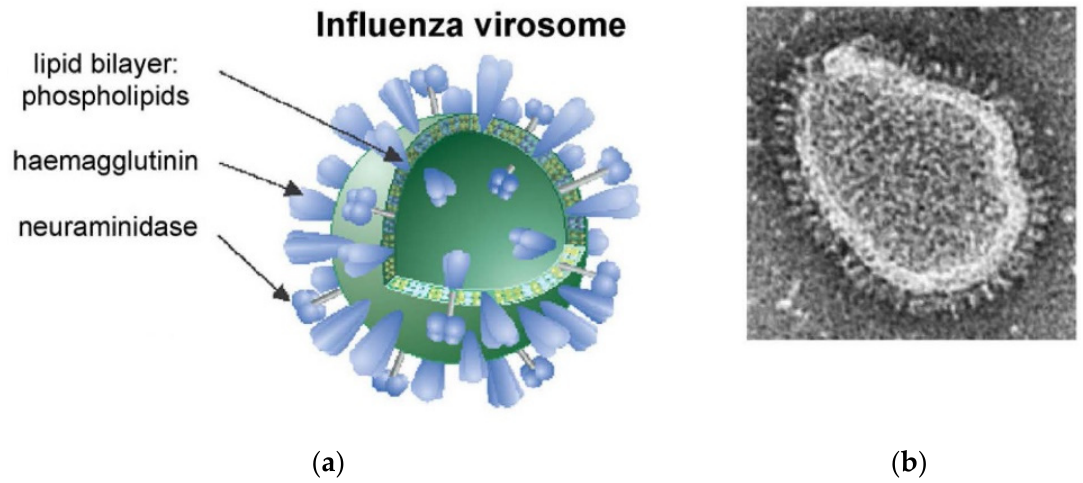
Figure 27. Application of lipid vesicles for vaccination. Schematic representation ( a ) and transmission electron microscopy image ( b ) of an influenza virosome (diameter: 150 nm) consisting of the phospholipids DOPC and DOPE (75:25, molar ratio) as membrane forming amphiphiles, with the two membrane-integrated antigene glycoproteins (“spike proteins”) haemagglutinin and neuramidase, as present in the vaccine product Inflexal ® V, as published by Herzog et al. (2009) [338]. This virosome preparation was made by using the “detergent-depletion method” [401,402]; see Chapter 4, Figure 17a. Reproduced with permission from [338], Elsevier,